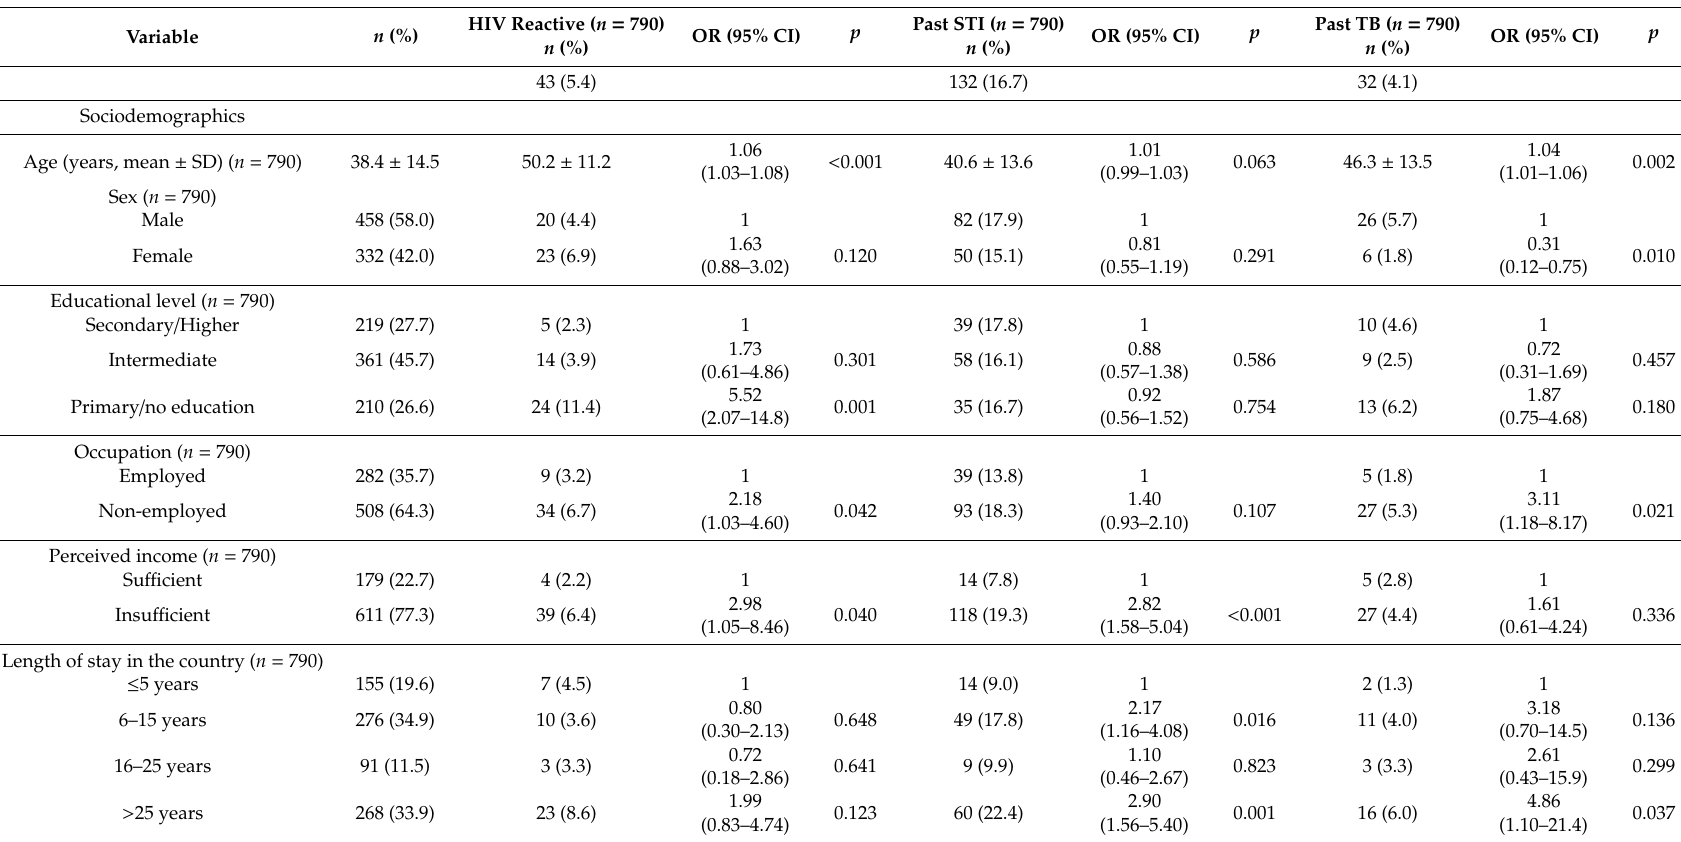
Table 1. Bivariable analysis of sociodemographics, sexual behaviors and infections correlated with HIV reactive test, past sexually transmitted infection (STI) and past Tuberculosis infection